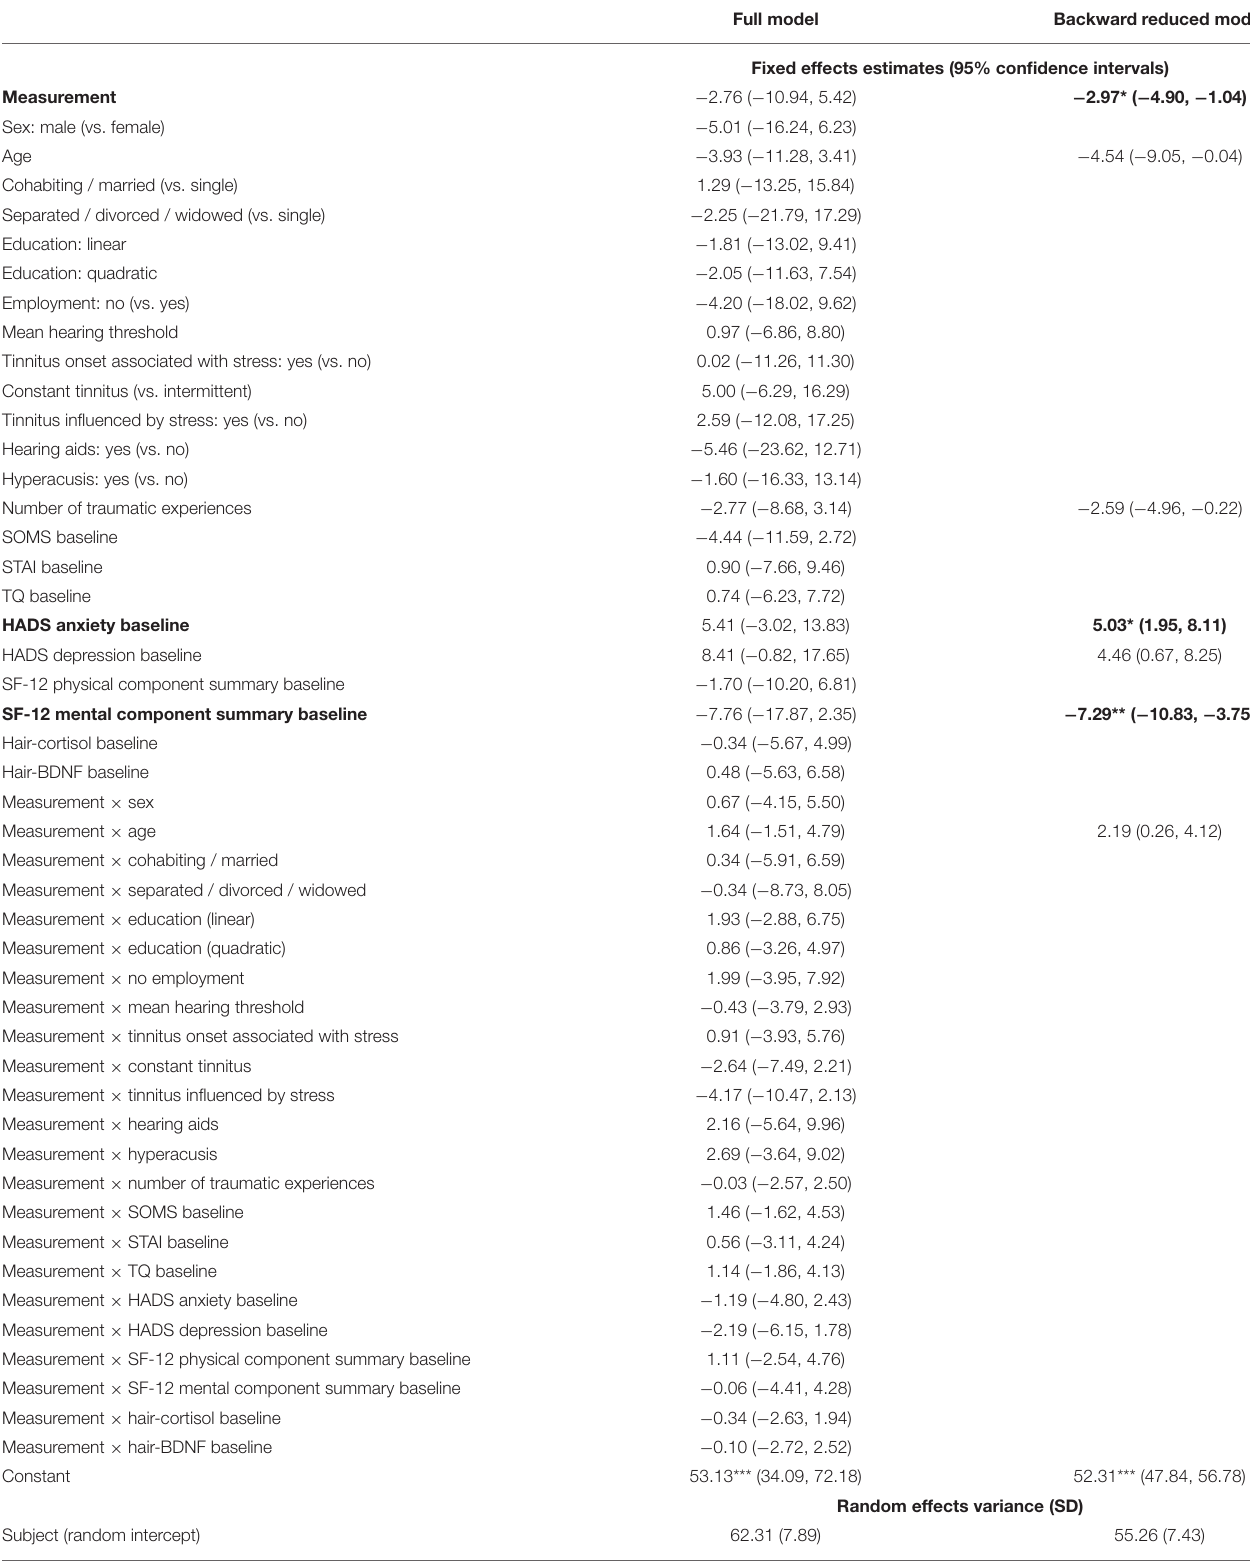
TABLE 4 | Full and backward reduced linear mixed-effects models for change in Perceived Stress Questionnaire (PSQ-20) scores across baseline, treatment end, and follow-up ( N =